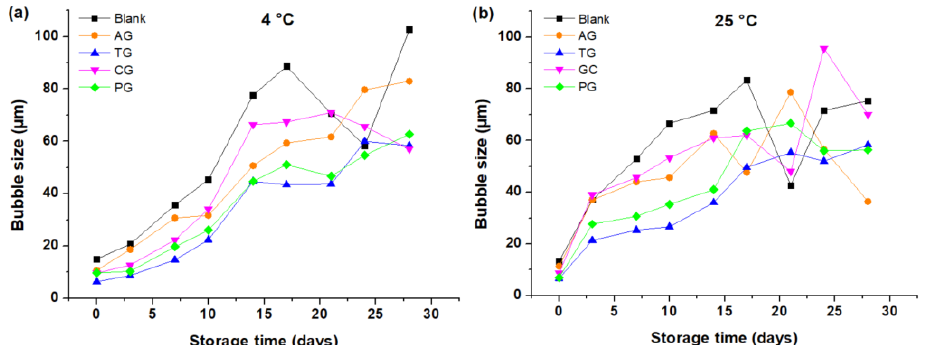
Figure 3. Bubble size depending on the storage time: ( a ) Creams stored at 4 °C; ( b ) Creams stored at 25 °C.